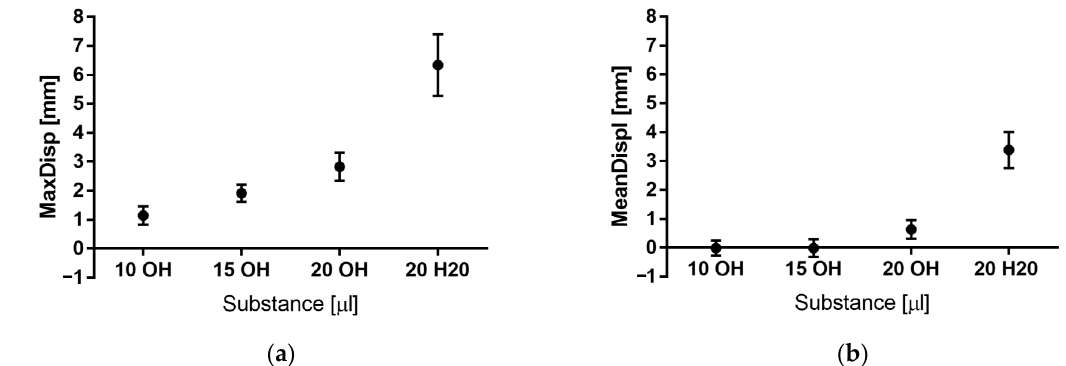
Figure 10. Mean values per study case: ( a ) Maximum displacement; ( b ) Mean displacement.